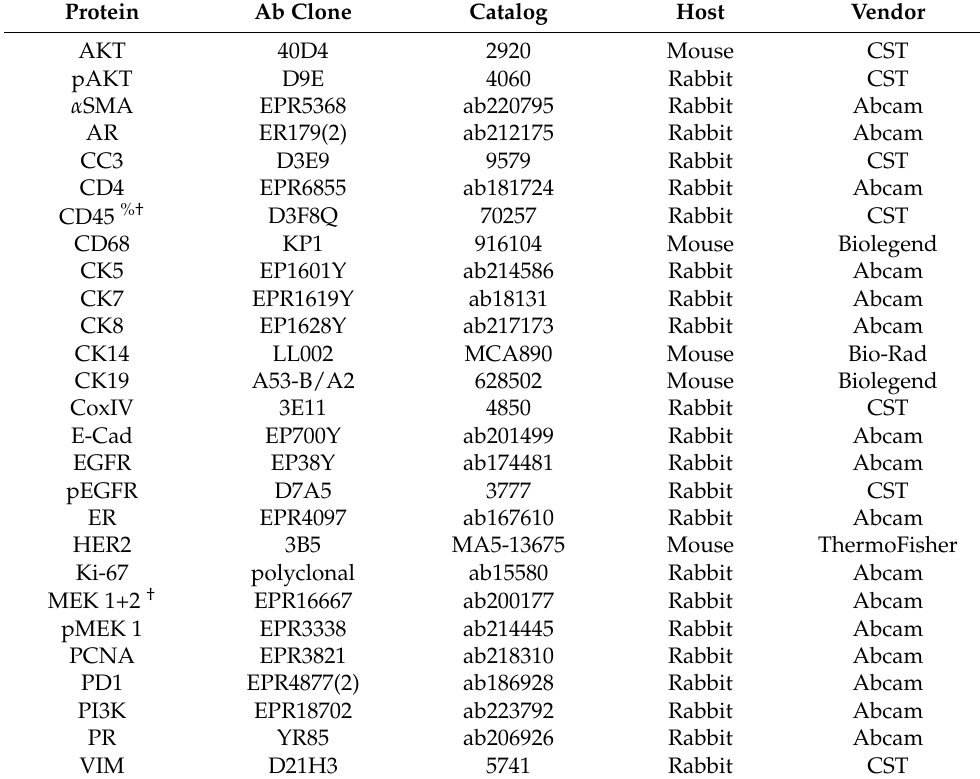
Table 1. Antibody-specific information.